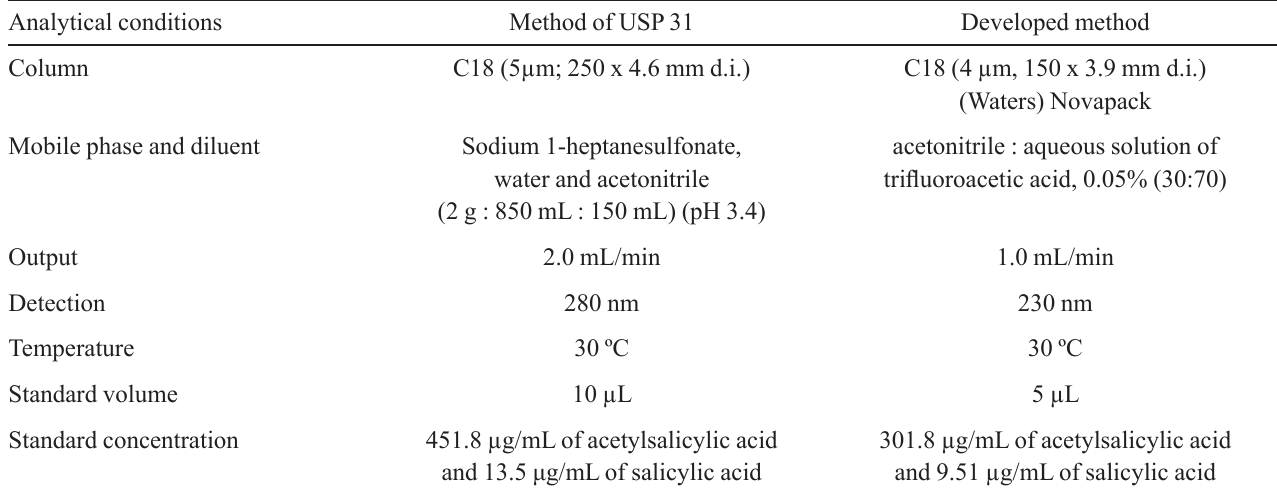
TABLE I - Analytical conditions of the literature method (USP) and the analytical method developed in this study, with samples injected in Waters and Shimadzu chromatographs